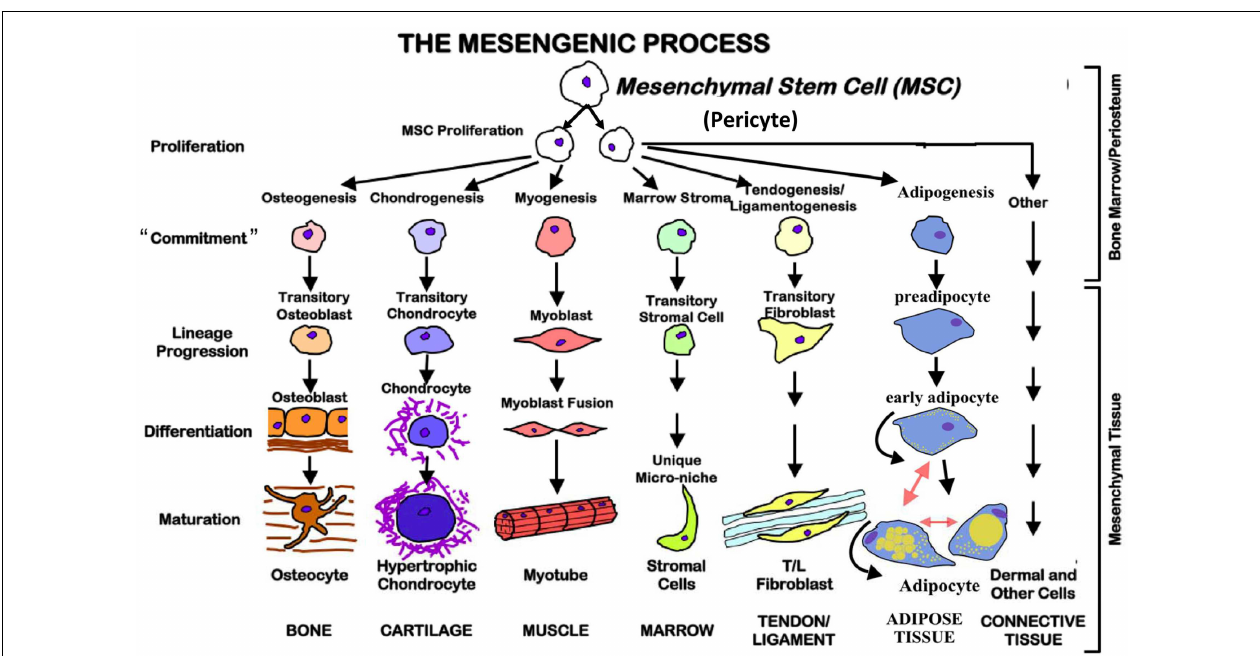
FIGURE 2 |The mesengenic process. Mesenchymal stem cells are multipotent and possess the ability to proliferate and commit to different cell types based on the environmental conditions.They also may be redirected from one lineage to another.